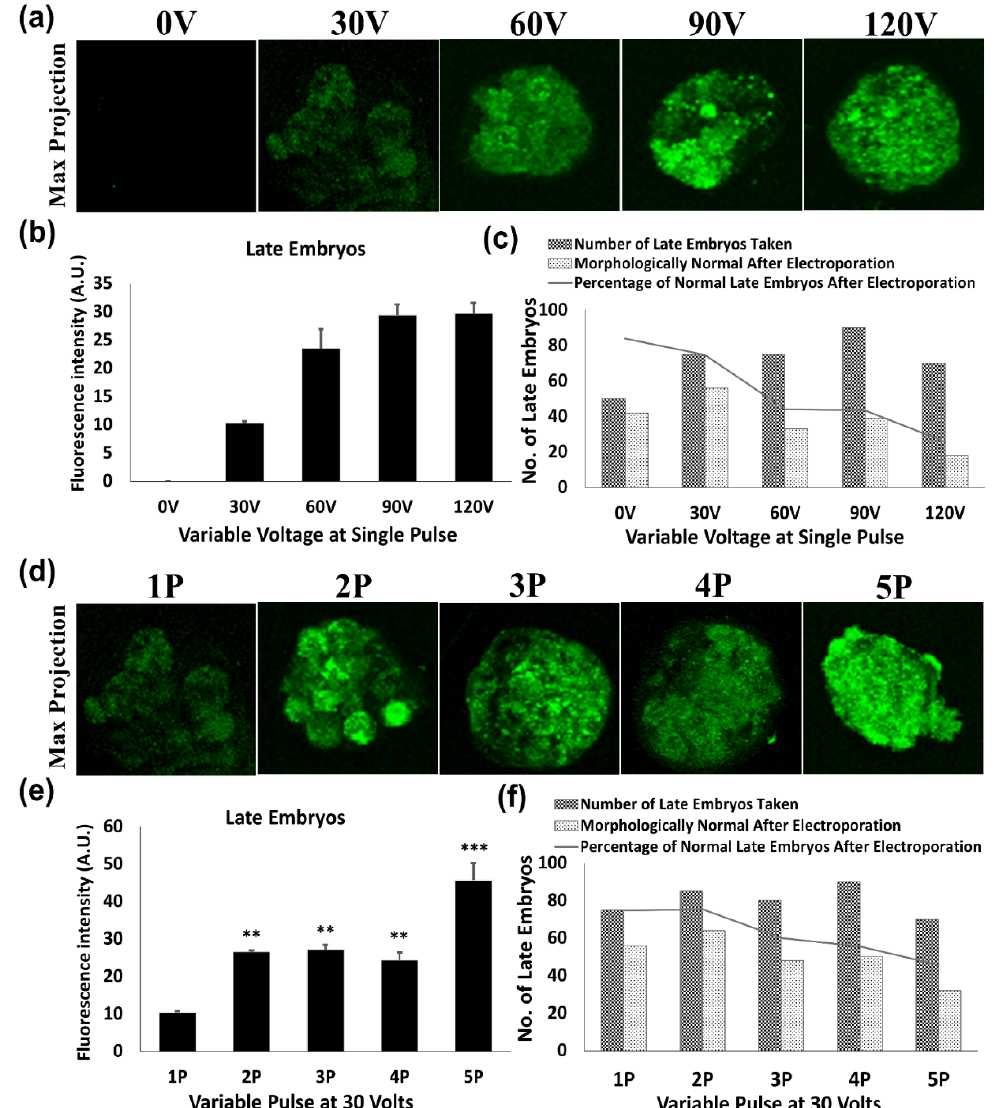
Figure 4. Assessment of GFP transfection by varying voltage and pulse in late mouse embryos following electroporation. ( a – c ) Higher voltages of more than 30 volts (60–120 V) at a single pulse resulted in the reduction in the survival of late mice embryos after electroporation; ( d – f ) on using the multi-pulse at 30 V, two pulses (30 V 2P) showed an optimal survival rate for the late embryos, which might be due to the zona hatching phenomenon ( χ 2 = 23.03, df = 8, p < 0.01). ** p < 0.01 and *** p < 0.001 indicate significant differences compared to the single pulse of 30 V. Original magnification of photomicrographs was ×400.